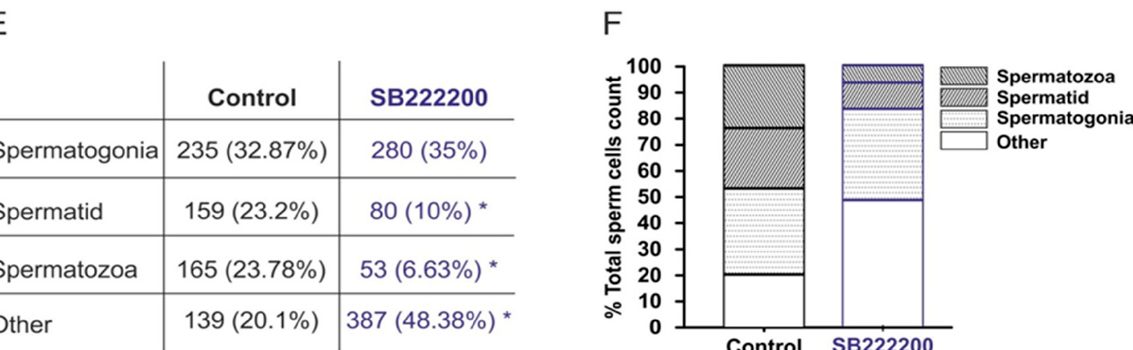
Figure 9. In vivo effect of NKB antagonist, SB - 222200, (Blue) compared to control group (Black) on sperm production and volume. Male tilapia were IP injected with SB - 222200 (500 μ g/kg BW in 25% DMSO), and saline with 25% DMSO as a control every 48 h during a 14-day period. Blood was sampled every 48 h for 11-KT ELISA analysis (Mean with 95% CI; n = 6 fish per group ( A ). Milt was sampled at 7th and 14th day of injections and its volume was measured. ( B ). At 14 days, testes were sampled for histology from control fish ( C ) or SB - 222200 injected fish ( D ). Different stages along spermatogenesis were estimated ( E , F ); * p < 0.05, ** p < 0.01.